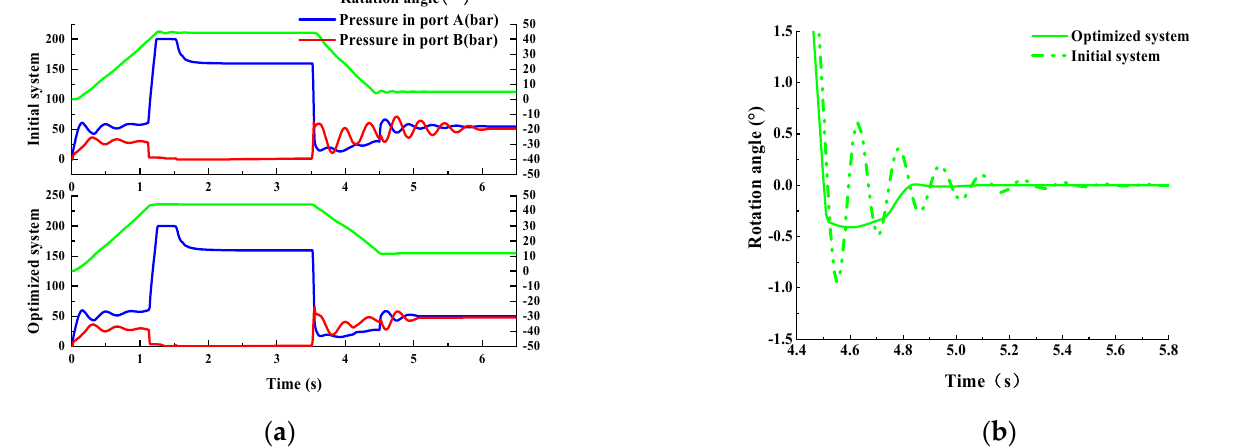
Figure 10. The emergency stop of the steering simulation result: ( a ) cylinder pressure and frame angle curve; ( b ) partial enlarged view of the steering angle.